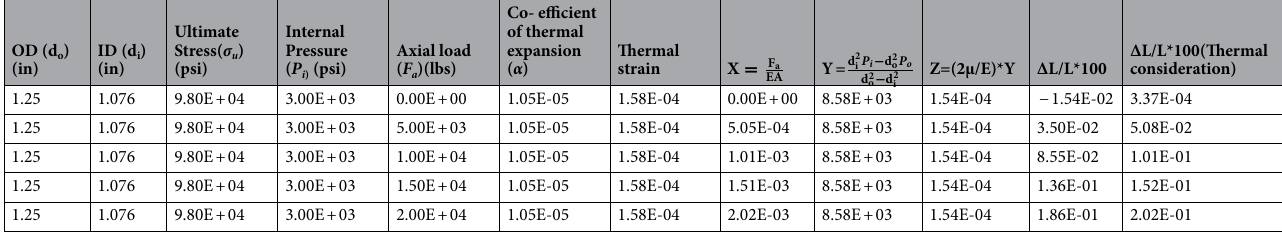
Table 21. CT Elongation for QT800 (HOC).